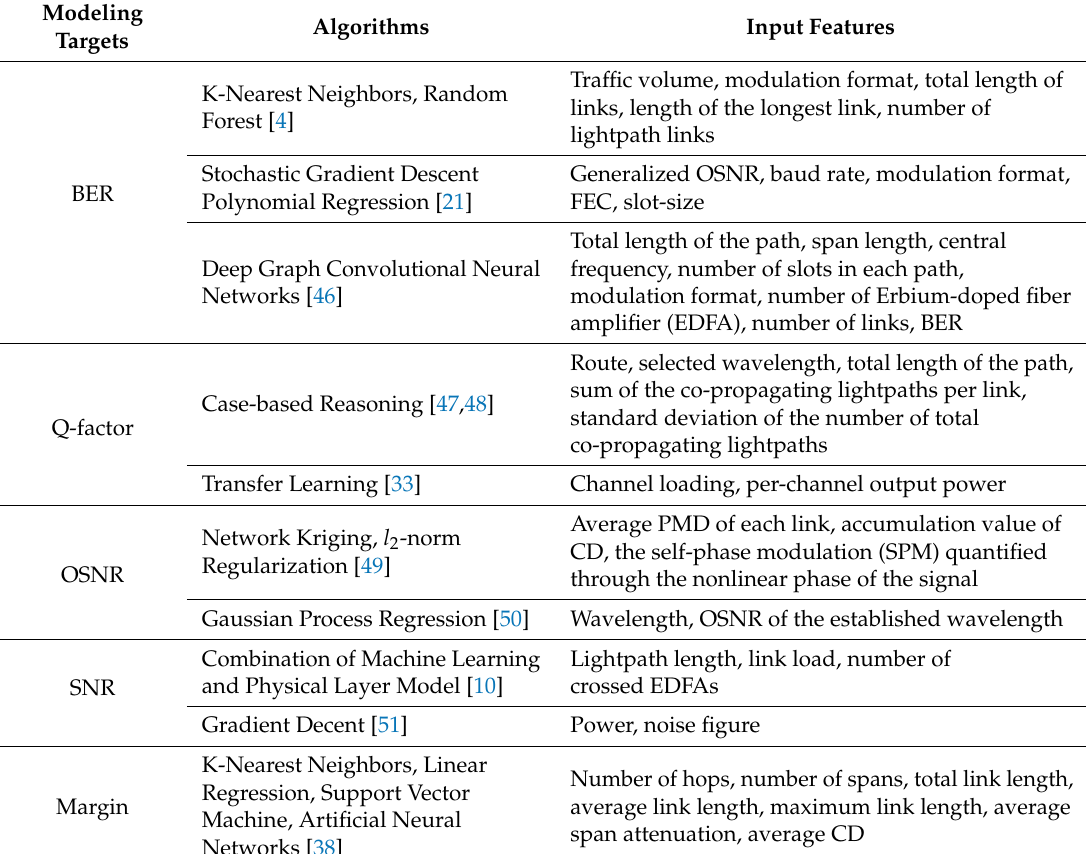
Table 1. Summary of the machine learning (ML)-based quality of transmission (QoT) modeling techniques discussed in Section